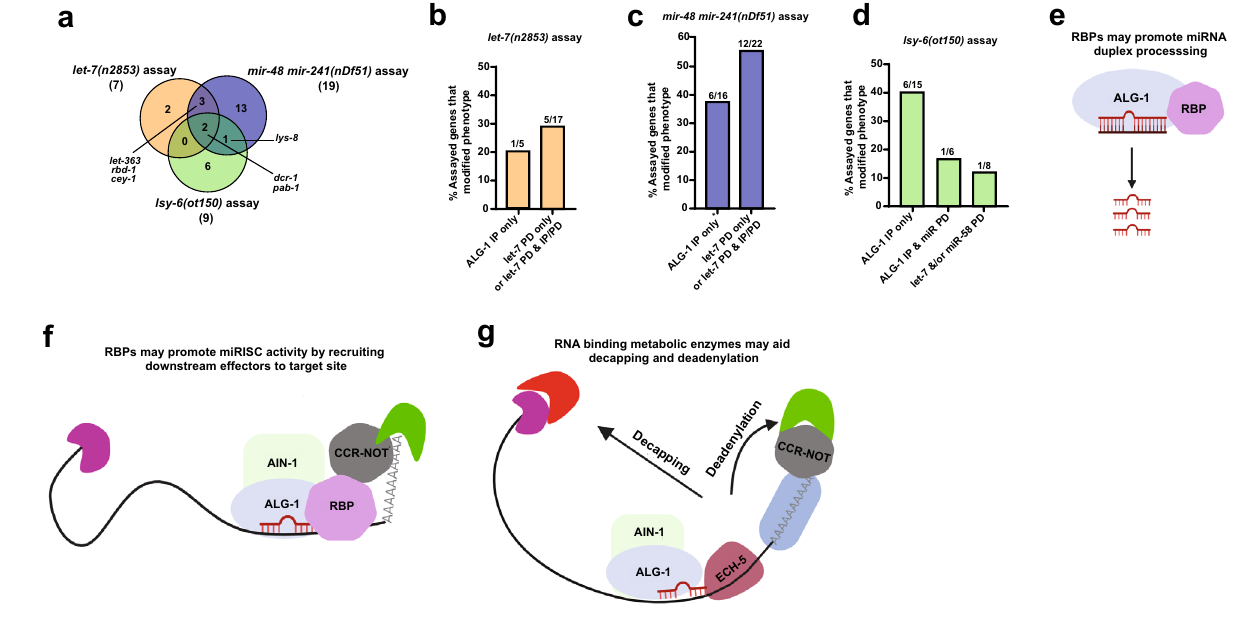
Figure 6. Summary of functionally relevant interactors and models for possible mechanisms through which miRNA and ALG-1 interactors affect gene regulation. ( a ) Venn diagram showing the overlap of functional hits among the three functional assays. ( b – d ) Percentages of assayed factors that modulated phenotypes upon their respective gene knockdowns in ( b ) let-7(n2853) , ( c ) mir-48 mir-241(nDf51) , and ( d ) lsy-6(ot150) assays, with protein physical interaction status shown on the x-axis. *One ALG-1 interactor was also identified in miR-2 pulldown in addition to ALG-1 IP. The number of genes that modulated miRNA phenotypes over total number of genes tested is shown above respective bars. ( e – f ) RNA binding proteins found interacting with ALG-1 as well as miRNAs could be involved in ( e ) miRNA duplex processing and/or ( f ) facilitating miRISC activity on the targets by associating with downstream effectors. ( g ) Metabolic enzymes with putative RNA binding ability, such as ECH-5, could bind target mRNAs and promote miRISC activity by recruiting deadenylases and decapping proteins. Panels ( e , f ), and ( g ) were drawn using BioRender (https:// biore nder.